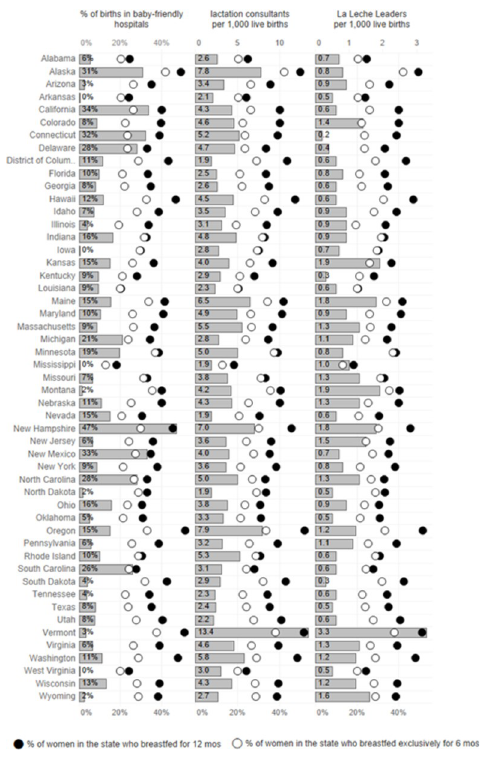
Fig 1. Distributions of breastfeeding support and practices for births in 2015, by state. https://doi.org/10.1371/journal.pone.0275021.g001 In multivariable models controlling for women’s status and the percentages of Black and Hispanic populations, only IBCLCs were positively associated with both outcomes among the breastfeeding supports (Table 2). There was a 5% increase in the rate of exclusive breastfeeding at six months and a 4% increase in the rate of breastfeeding at 12 months with each additional IBCLC per 1000 population, controlling for women’s status. Neither La Leche League leaders nor births in Baby Friendly hospitals had a statistically significant association with either exclu- sive breastfeeding at six months or breastfeeding at 12 months in multivariable models (Table 2).